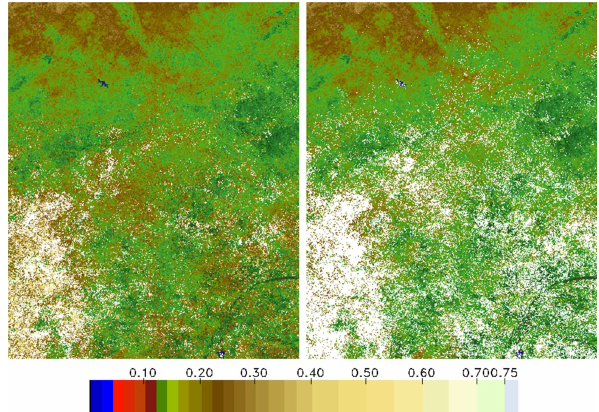
Figure 14. Cloud screening example for Meteosat-7. The period is 1–10 May 2001. The original MSA product is shown on the left panel and the cloud-decontaminated one on the right